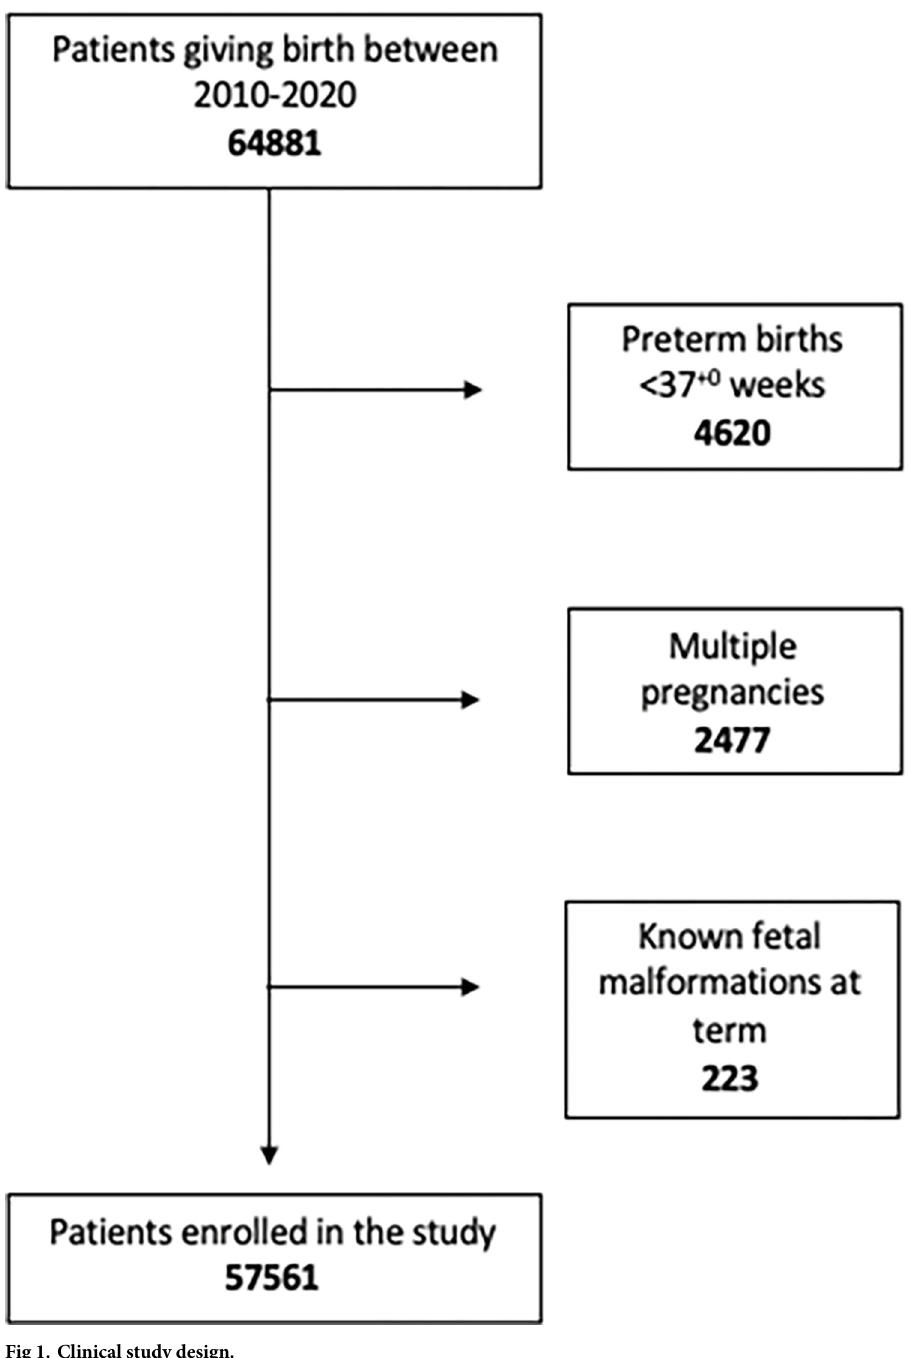
Fig 1. Clinical study